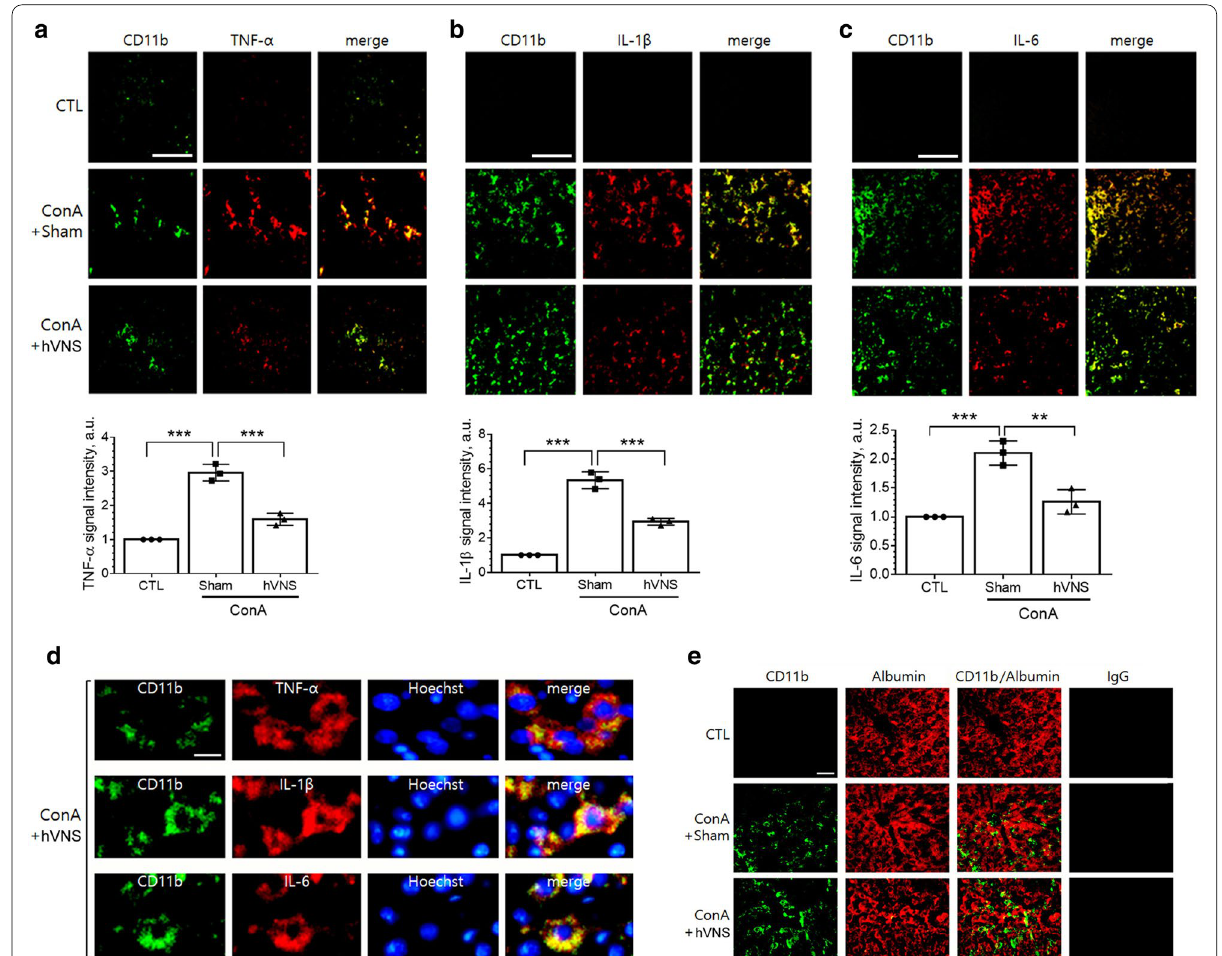
Fig. 2 Immunofluorescence localization of TNF‑α, IL‑1β and IL‑6 in the liver tissue of animals treated with ConA or ConA hVNS. a – c Representative + immunofluorescence images of TNF‑α, IL‑1β, and IL‑6 that were merged with CD11b. Signal intensities of TNF‑α, IL‑1β, and IL‑6 from 4 to 6 images were averaged per each animal and compared among experimental groups (n 3 independent experiments). One‑way ANOVA with Tukey = post hoc is shown. *p < 0.05, **p < 0.01, ***p < 0.001. d Enlarged views of TNF‑α, IL‑1β, and IL‑6 signals merged with CD11b and Hoechst nuclear staining images in the liver sections from ConA hVNS animal. e Immunofluorescence staining of liver tissue with anti‑CD11b and anti‑albumin + antibodies. Representative immunofluorescence images using normal mouse IgG antibody instead of primary antibodies followed by reaction with fluorescein‑goat anti‑mouse IgG antibody are shown in the last column. Scale bars in a – c , d , and e are 100 μm, 10 μm, and 50 μm